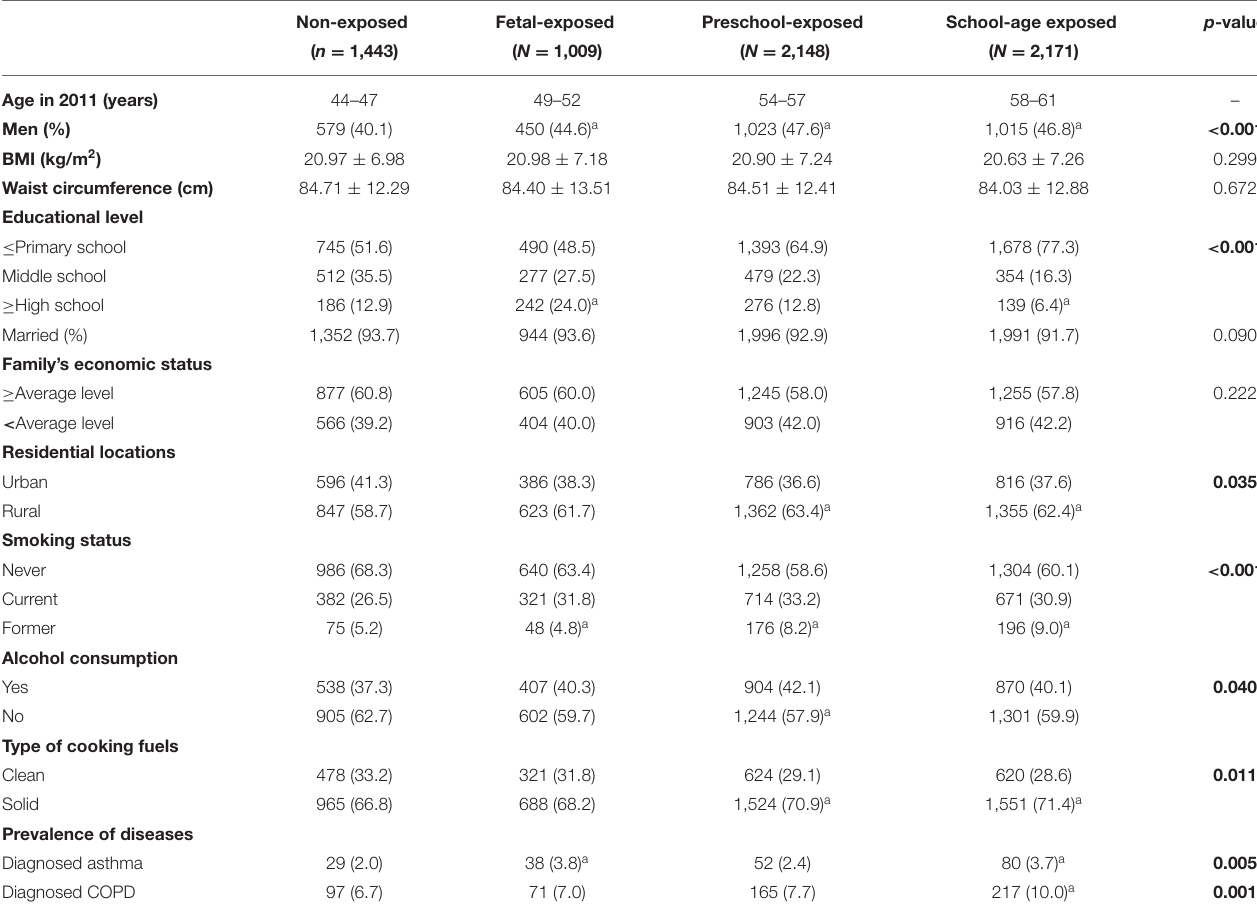
TABLE 1 | Sociodemographic characteristics and prevalence of asthma and COPD among the participants according to the famine exposure groups.